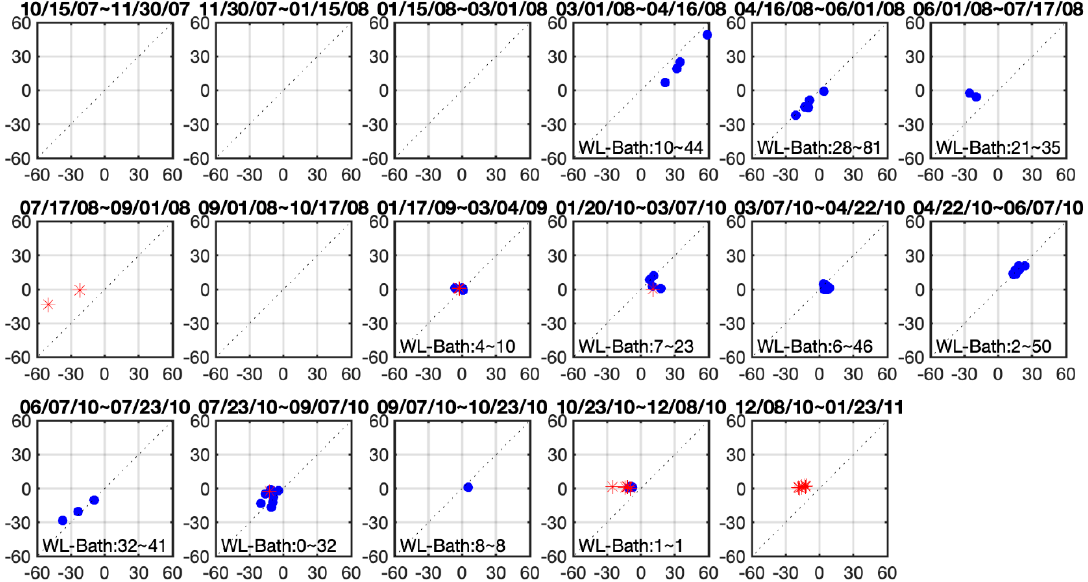
Figure 13. Water level change retrieval by InSAR pair as listed in Table 3. (blue dots: water level above the wetland elevation; red dots: water level below the wetland elevation) (WL stands for water level and Bath stands for the wetland elevation from USGS DEM. The numerical range in each plot if any is for blue dots only.) (No valid points for InSAR pairs 1, 2, 3, and 8) (Horizontal axis: Δ𝑊𝐿 in situ measurement in cm; Vertical axis: Δ𝑊𝐿 retrieval in cm) (pair index enumerated in Table 3)